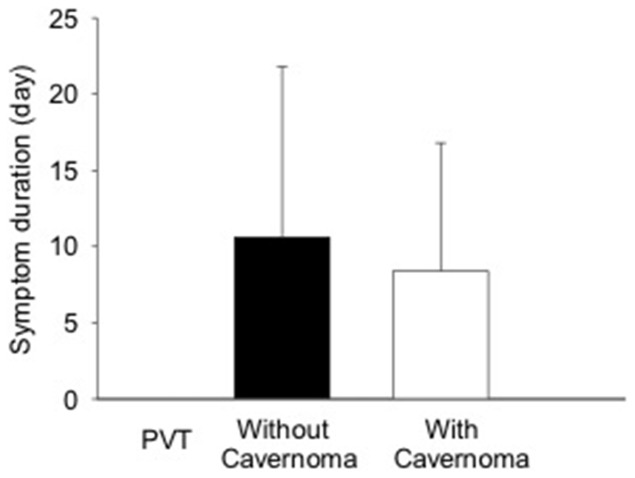
Comparison of symptom duration between PVT patients with and without portal cavernoma.There was no significant difference in symptom duration between two groups.